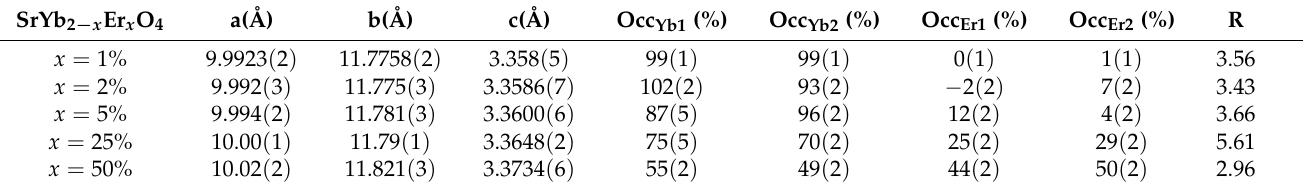
Figure 2. Observed, calculated, and difference profiles from the Rietveld refinement of the FIREPOD data collected at room temperature for all samples. The calculated patterns (red lines) are compared with the observed ones (black dots). The blue line represents the difference between them and the green bars indicate the (h,k,l) positions. Table 1. Lattice parameters, occupations, and R-factors obtained from the refinement of the FIREPOD data (for Er1%, Er2%, Er5%, and Er50%) at room temperature and DMC data (for Er25%) at